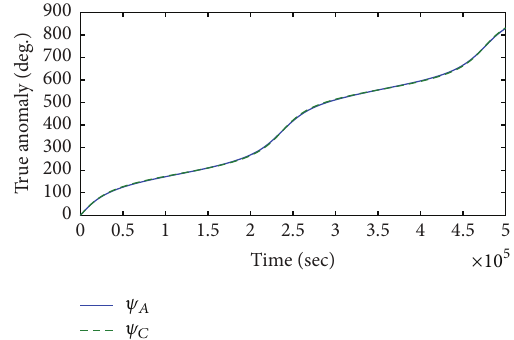
Figure9:Trueanomalyasfunctionoftimeforaprescribedfunction (𝑡) . 𝐿 1